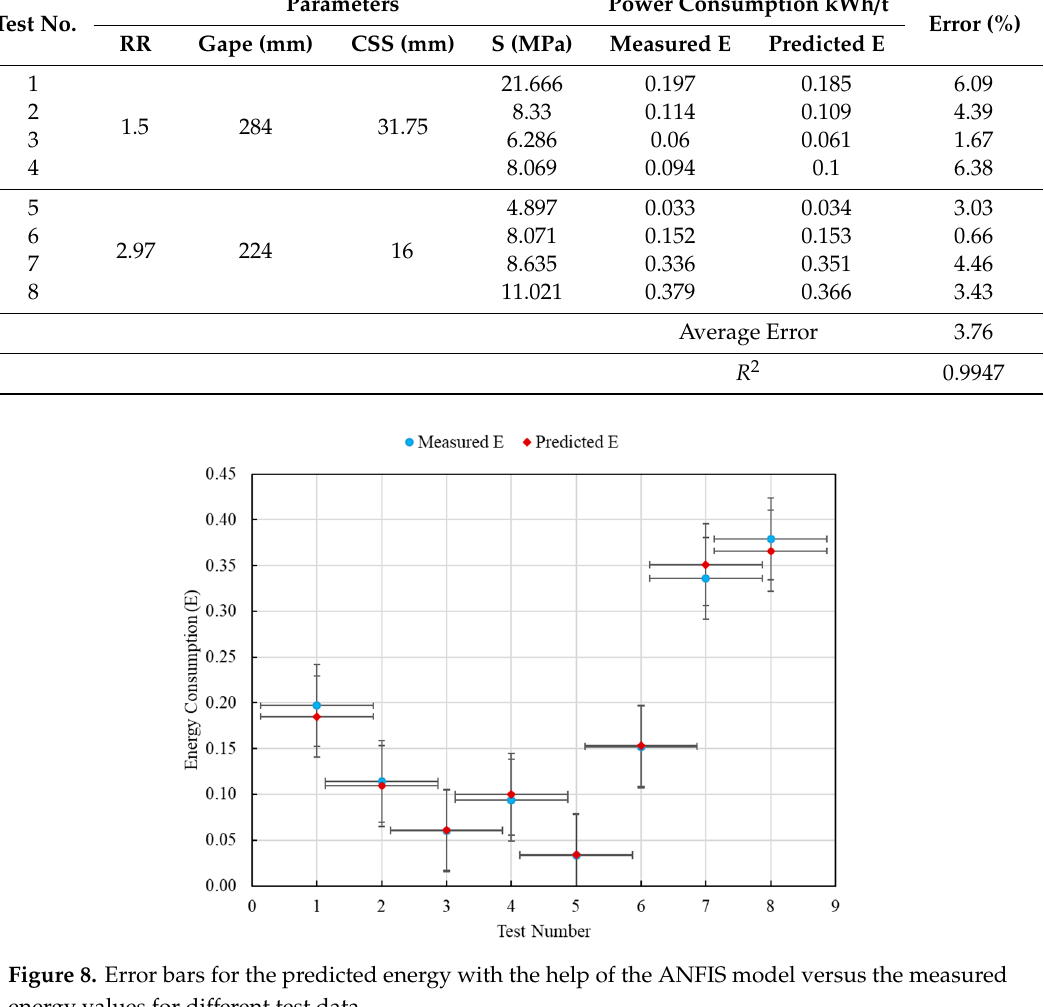
Figure 8. Error bars for the predicted energy with the help of the ANFIS model versus the measured energy values for different test data.